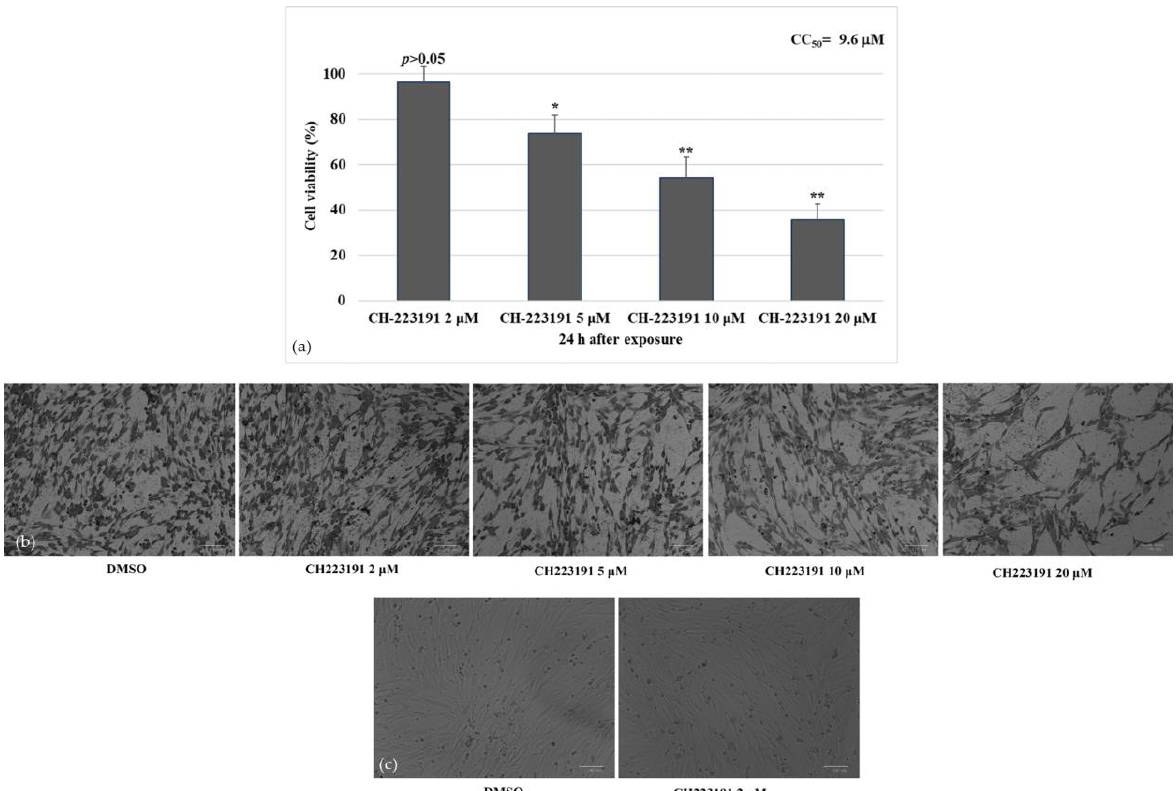
Figure 1. Identifying CC 50 of CH223191 inhibitor at different doses and developing dose–response curve in A72 cells. ( a ) Dose–response curve of A72 cells treated with CH223191 at different concentra- tions (2, 5, 10 and 20 µ M). After 24 h of treatment, cell viability was determined by TB staining while cells were attached to wells and counted under a light microscope. Significant differences between DMSO and CH223191-treated cells are indicated by probability p . * p < 0.05 and ** p < 0.01. ( b ) At 24 h after treatment, cells were stained with Giemsa and observed under a light microscope. ( c ) A72 cells treated with DMSO or with CH223191 (2 M). Scale bar 100 µm.